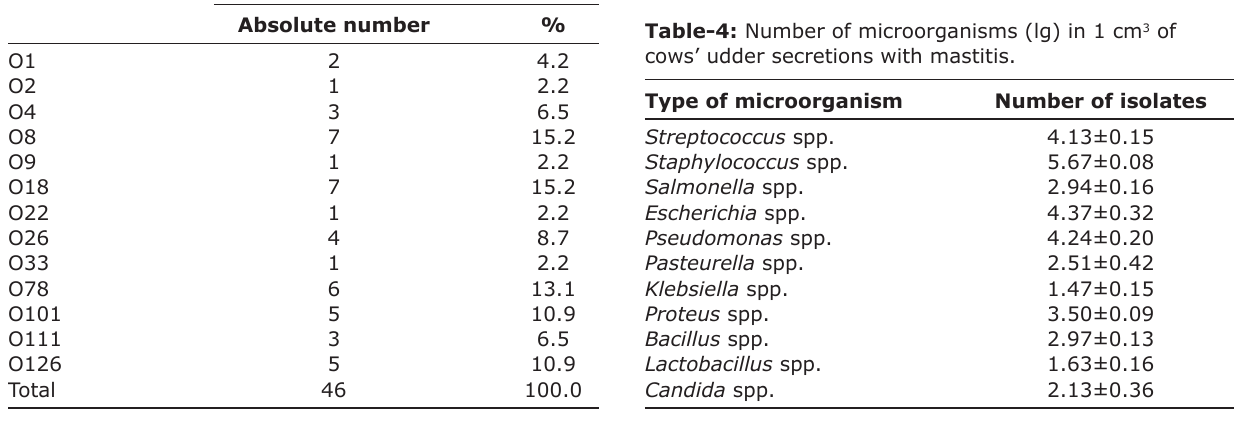
Table-3: Serological identification of Escherichia coli cultures, allocated from cows with mastitis. Serogroup